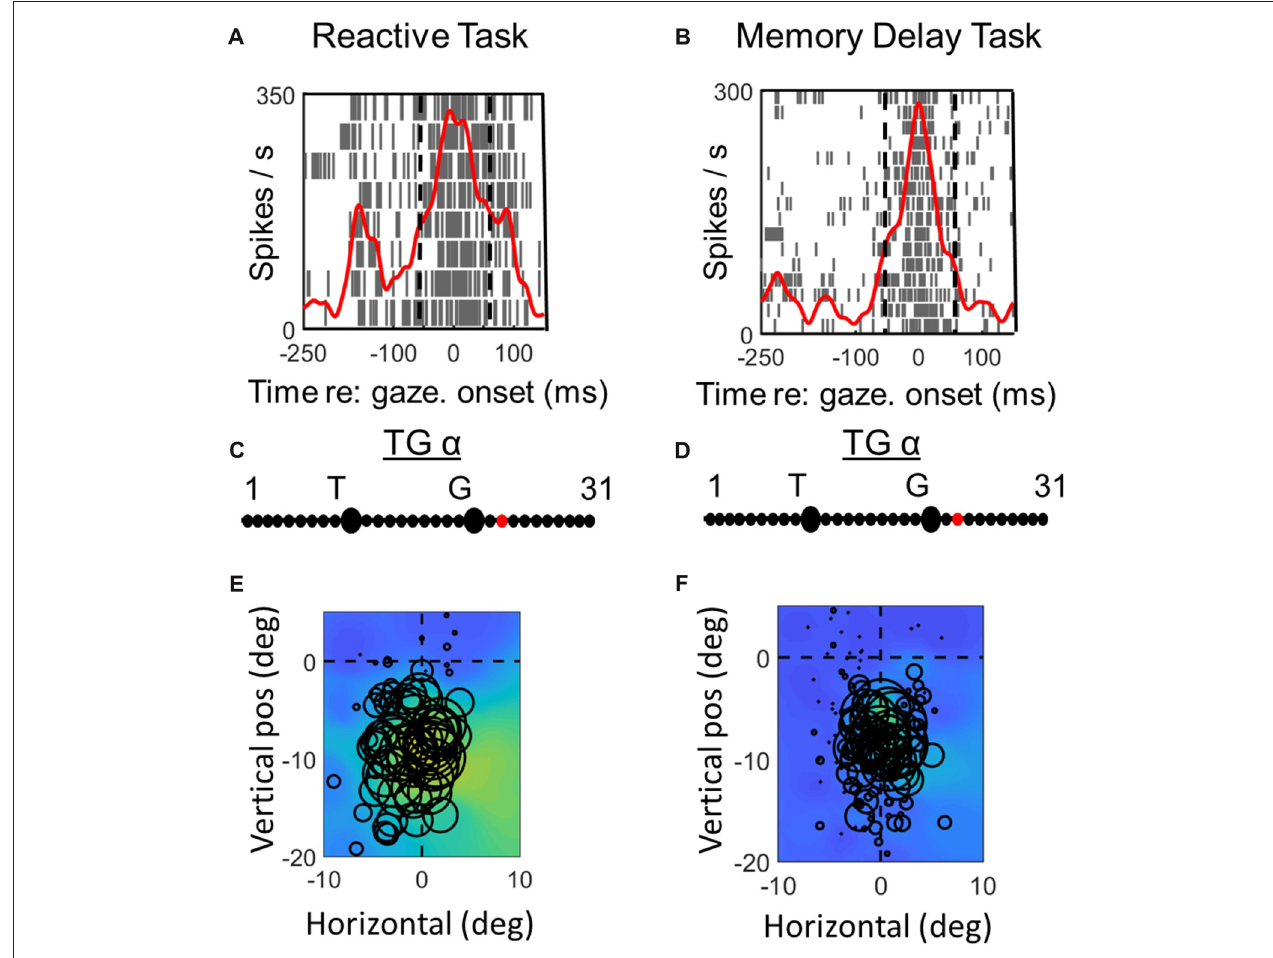
FIGURE 6 | Spatial analysis of motor activity during reactive task (left column) vs. memory delay task for one example VM neuron. Vertical dashed lines in (A,B) represent the fixed motor analysis windows ( − 50 to + 50 ms relative to gaze onset). Otherwise the plotting conventions are the same as in Figure 3